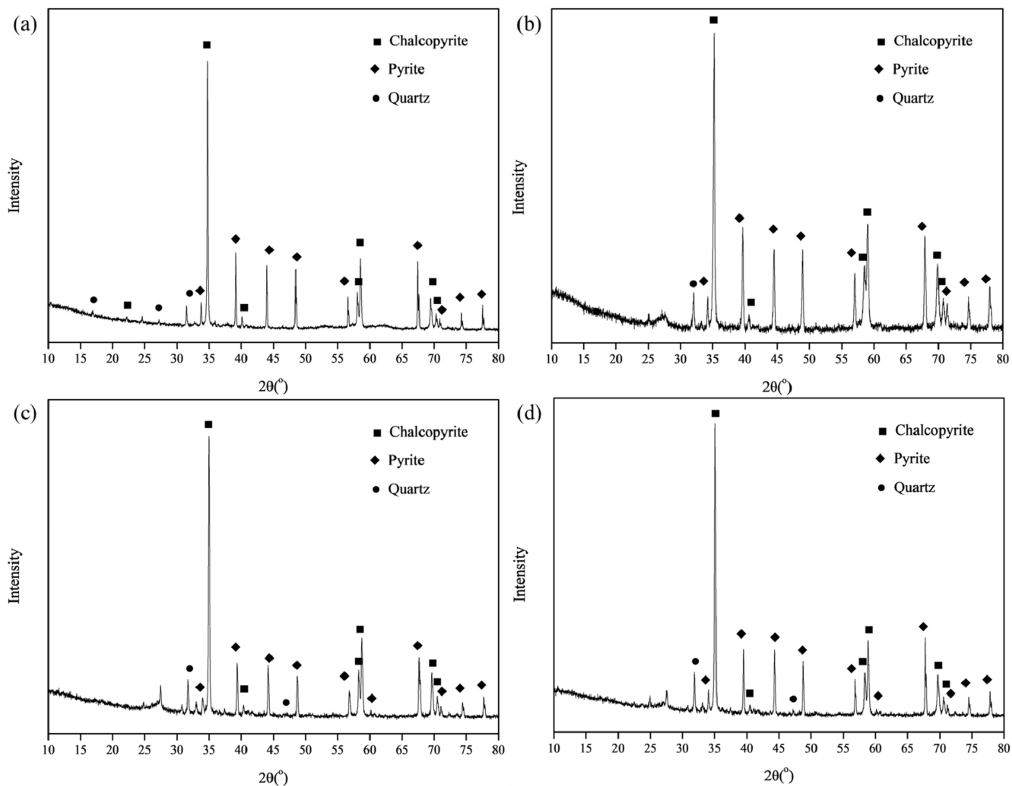
Figure 10. X-ray di ff raction patterns of the chalcopyrite-leached residues: ( a ) non-UAL at 50 ◦ C;